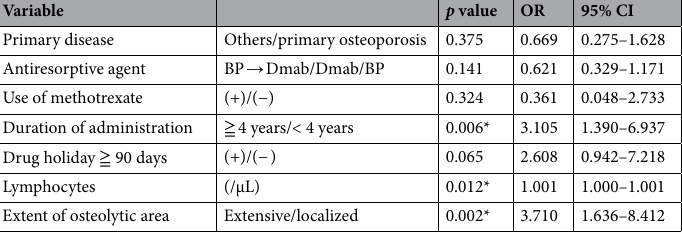
Table 3. Relationship between each variable and sequestrum separation (multivariate logistic regression). *Significant. BP: bisphosphonate, Dmab: denosumab, OR: odds ratio, 95% CI: 95% confidence interval.